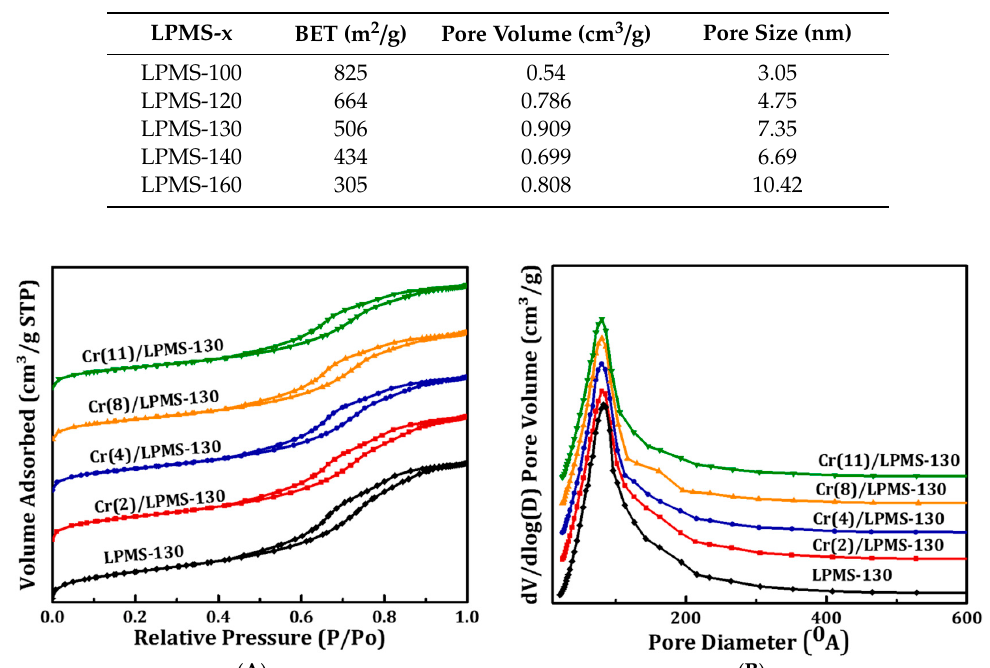
Figure 1. ( A ) N 2 sorption isotherms and ( B ) pore size distribution of LPMS-x prepared at different hydrothermal temperatures. LPMS: large-pore mesoporous silica. Table 1. Textural properties of LPMS-x prepared at different hydrothermal temperatures.